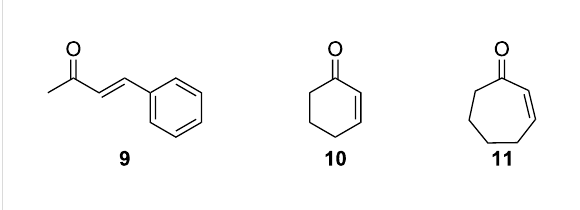
Figure 2: Michael acceptors employed as substrates in the nucle- ophilic addition of 4-hydroxycoumarin ( 1 ).